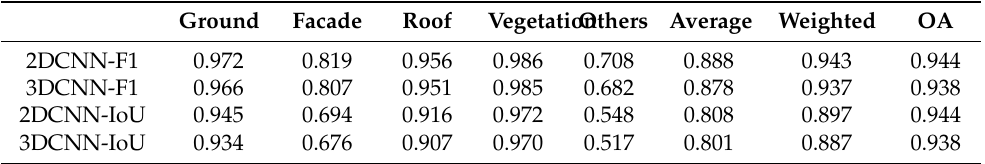
Table 10. Average and weighted F1 and IoU scores for 2DCNN and 3DCNN classifiers for the Bordeaux dataset. The OA is also reported.